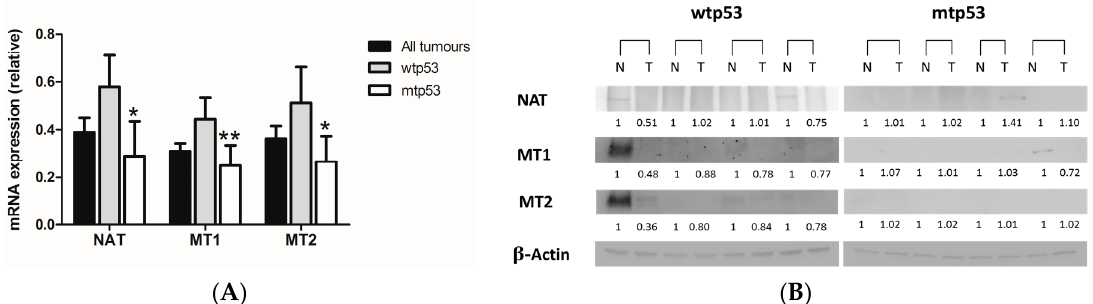
Figure 1. ( A ) mRNA expression of arylalkylamine N-acetyltransferase (AA-NAT), MT1, and MT2 in all patients, patients with wtp53 tumors and patients with mtp53 tumors. Data represent mean ± S.E.M. * p < 0.05 versus wtp53; ** p < 0.01 versus wtp53; ( B ) Protein expression of AA-NAT, MT1, and